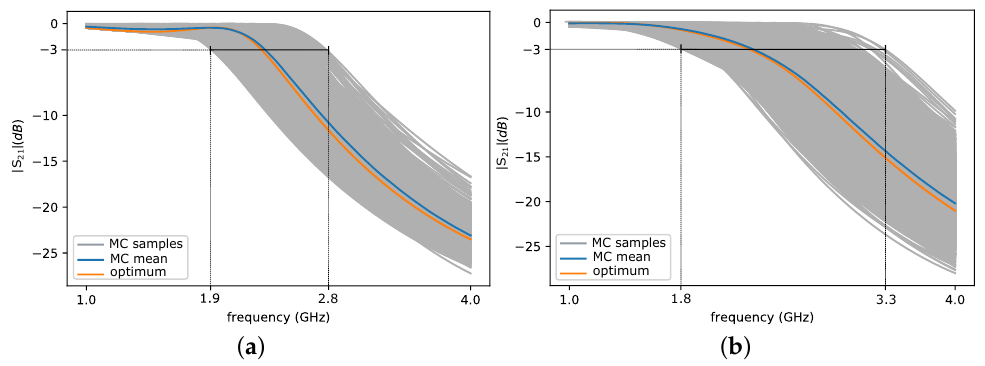
Figure 7. ( a ) Transmission characteristic | S 21 | of the lowpass filter using the robust methodology and ( b ) standard BO. ( a ) The optimal 3 dB cut-off frequency found by the robust BO is 2.38 GHz, and MC analysis reveals that it varies in the [1.9, 2.8] GHz range; ( b ) The optimal 3 dB cut-off frequency found by the standard BO is 2.40 GHz, and MC analysis reveals that it varies in the [1.8, 3.3] GHz range.